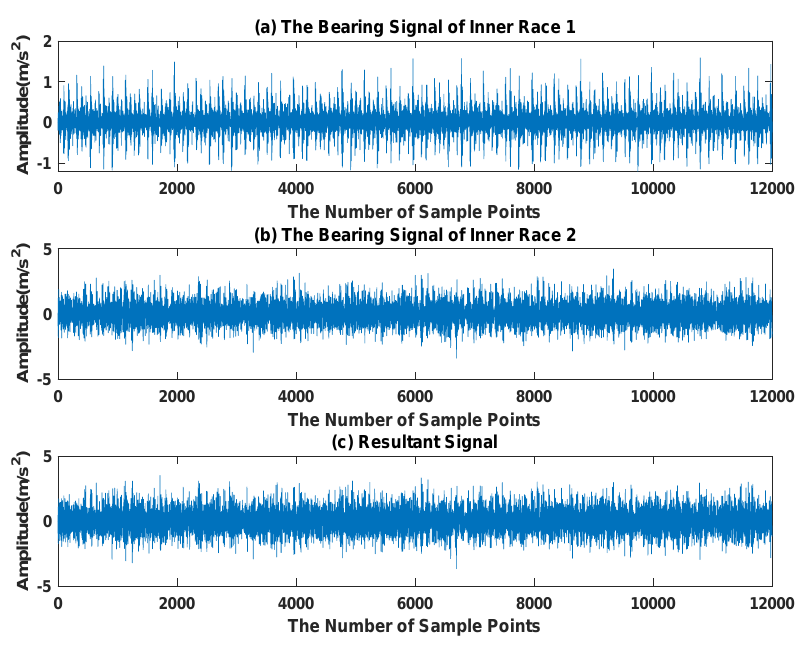
Figure 17. The Waveform of Composite Signal.